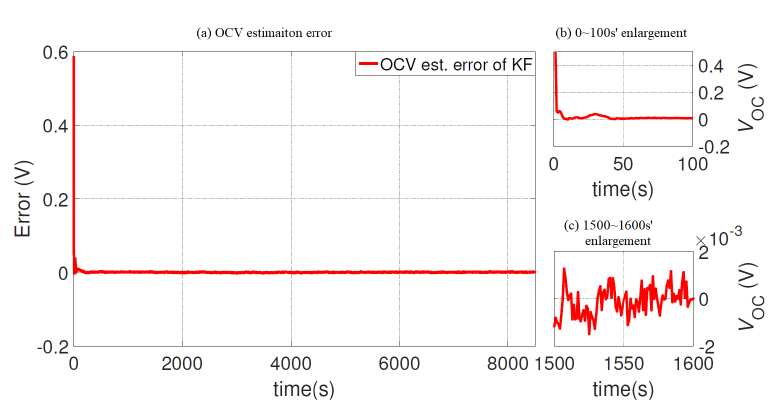
Figure 13. Estimation error of the battery